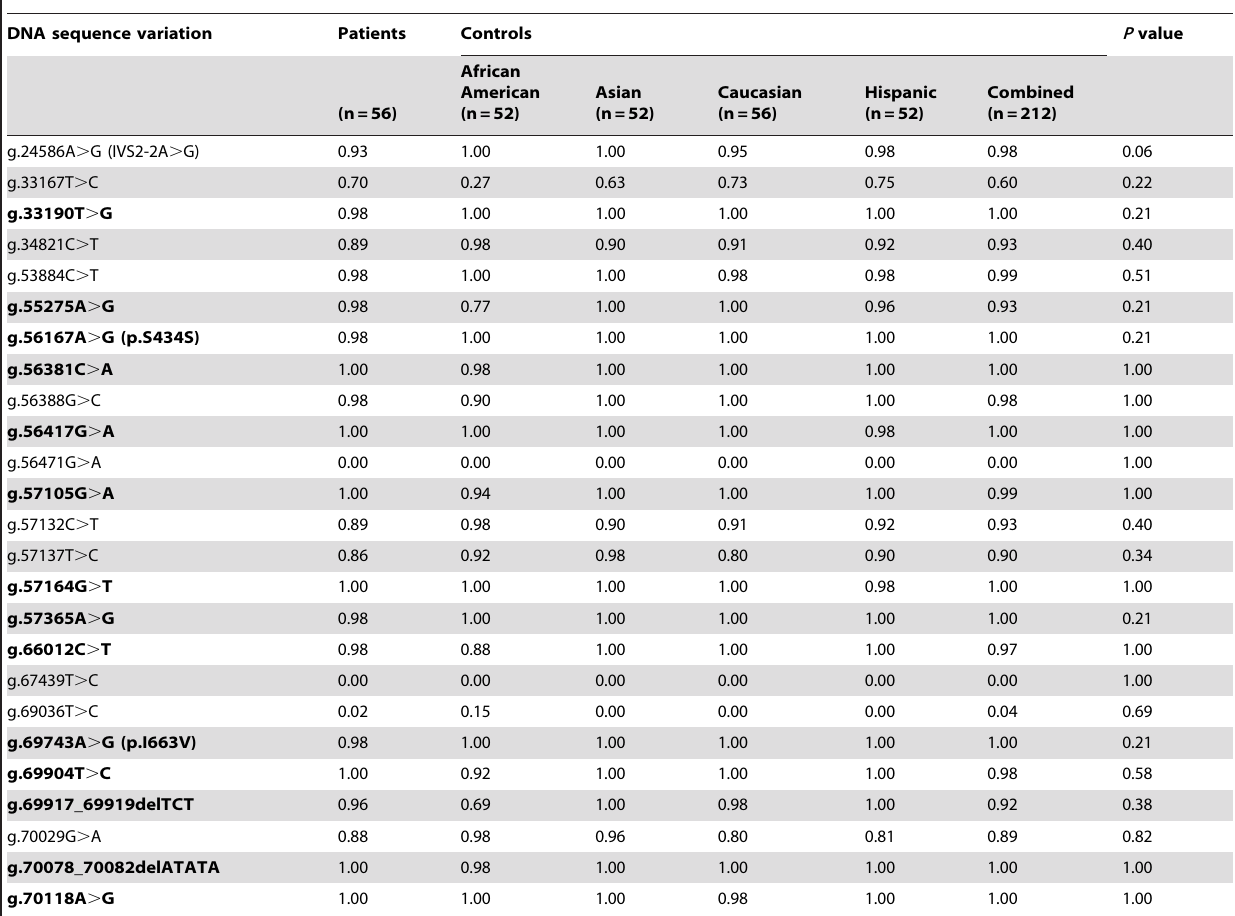
Table 2. Reference sequence allele frequencies for variations in SLC26A5 .